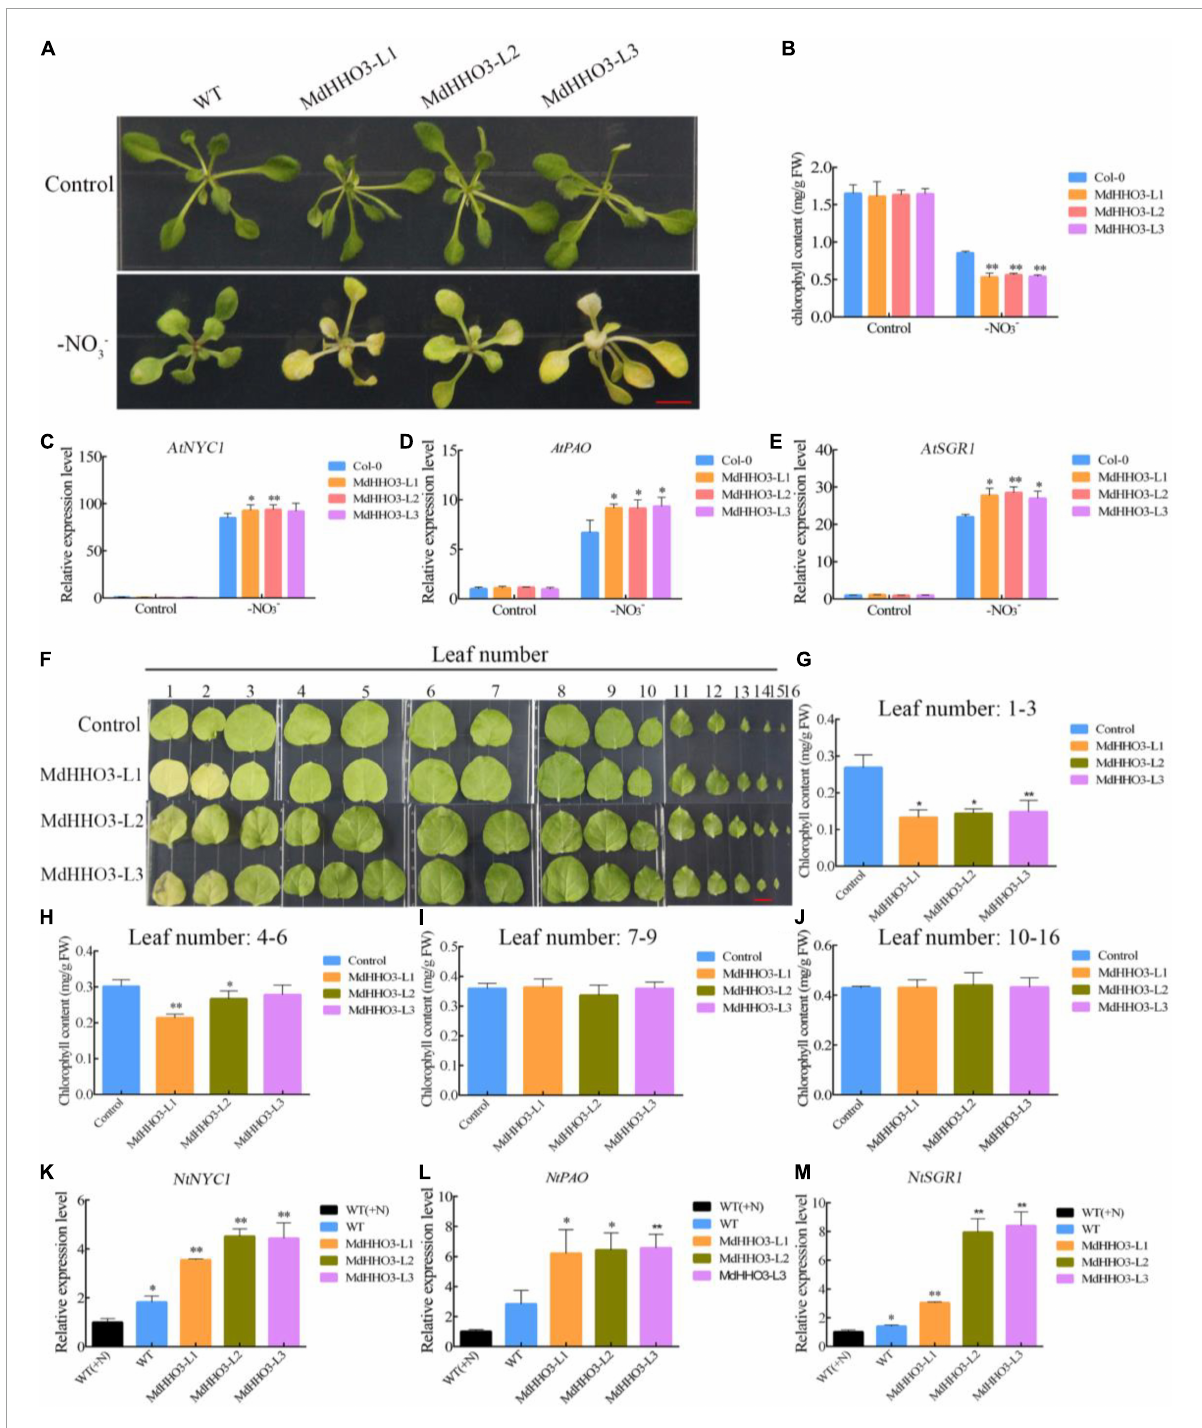
FIGURE8 Overexpression of MdHHO3 causes early senescence in Arabidopsis and tobacco. (A) Phenotypes of wild-type (Control) and transgenic Arabidopsis plants ( MdHHO3 ) after 4 days of nitrate deficiency treatment. (B) Total chlorophyll content in Arabidopsis leaves. (C–E) Expression of the senescence-related genes ( AtSGR1 , AtNYC1, and AtPAO ) in Arabidopsis after exposure to nitrate deficiency for 4 days. (F) Phenotypes of wild-type (Control) and transgenic tobacco ( MdHHO3 ) leaves after 30 days of nitrate deficiency treatment. (G–J) Total chlorophyll content in tobacco leaves 1–3, 4–6, 7–9, and 10–16. (K–M) Expression of the senescence-related genes ( NtSGR1 , NtNYC1 , and NtPAO ) in tobacco after exposure to nitrate deficiency for 30 days. The data are expressed as the means ± SDs ( n = 3). Significant differences were detected by a t -test: * P < 0.05 and ** P <